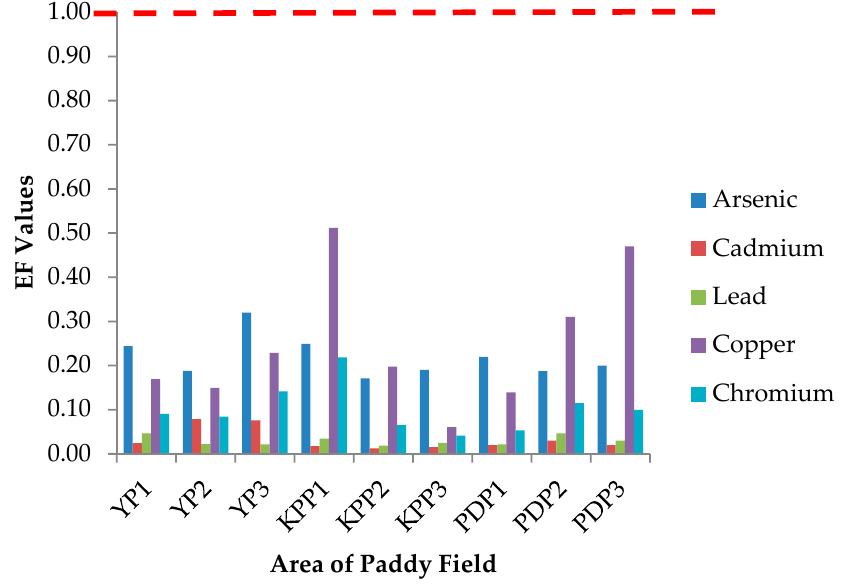
Figure 2. Enrichment factor (EF) from the soil to grain of paddy in areas of Yan, Kubang Pasu, and Pendang. YP1: Yan Plot 1, YP2: Yan Plot 2, YP3: Yan Plot 3, KPP1: Kubang Pasu Plot 1, KPP2: Kubang Pasu Plot 2, KPP3: Kubang Pasu Plot 3, PDP1: Pendang Plot 1, PDP2: Pendang Plot 2, and PDP3: Pendang Plot 3.